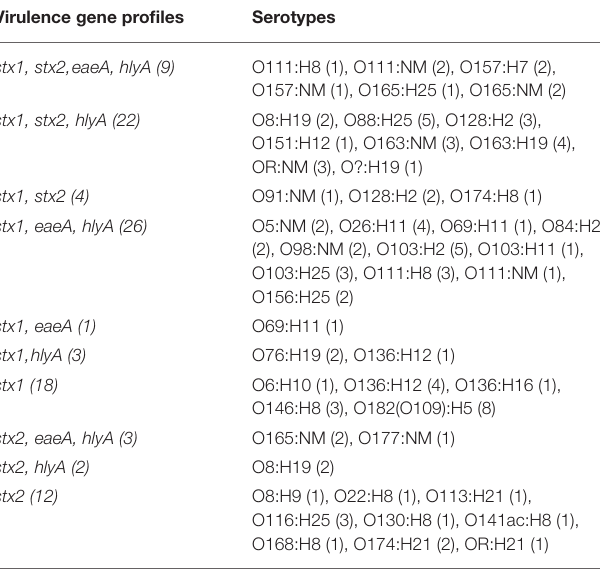
TABLE 3 | Correlation of temperature and precipitation with STEC recovery from surface waters in the Lower Mainland of British Columbia. Environmental factor a Correlation with STEC occurrence